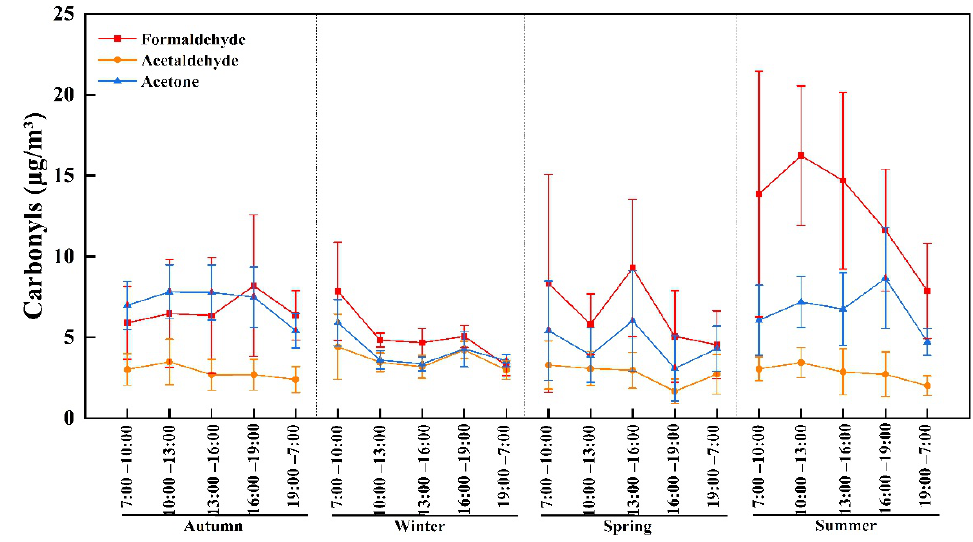
Figure 4. Diurnal variations of formaldehyde, acetaldehyde and acetone in the four seasons.